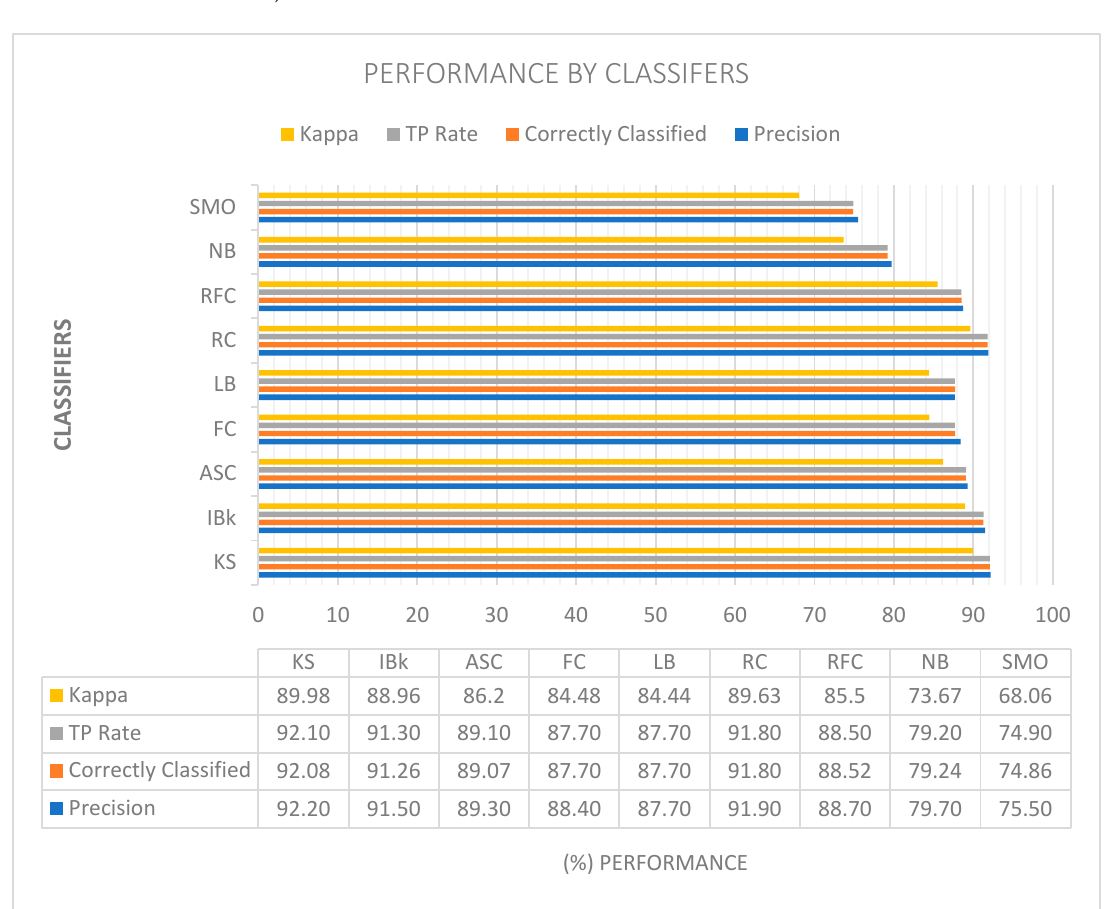
Figure 12. Comparison of classifiers’ performance (Kappa, TP Rate, Correctly Classified, Precision).